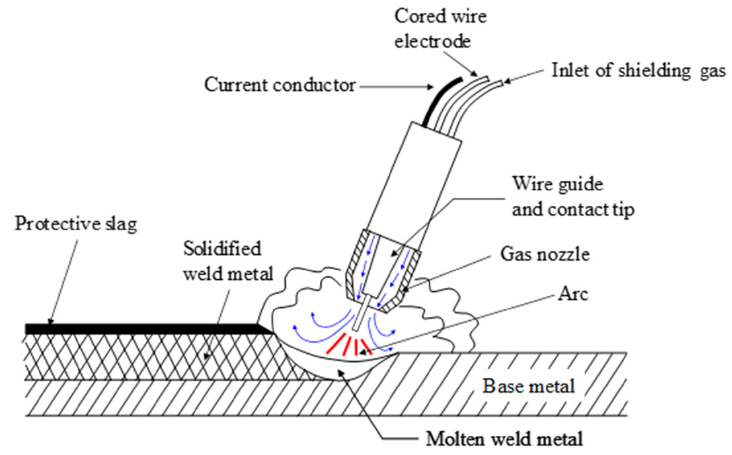
Figure 1. Configuration of gas metal arc welding (GWAM).